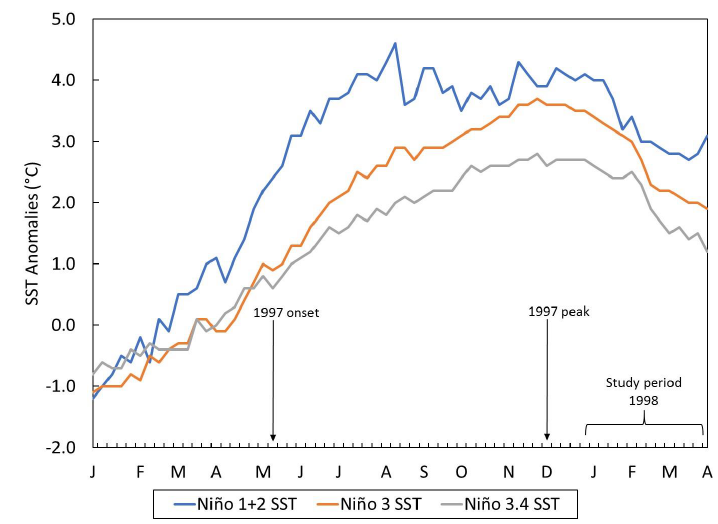
Figure 2. Weekly time plot of sea surface temperature anomalies (°C) in the central eastern (Niño 3.4), eastern (Niño 3) and coastal upwelling (Niño 1 + 2) regions of the equatorial Pacific Ocean from January 1997 to April 1998. El Niño onset and peak (based on ONI index) and study period are highlighted.